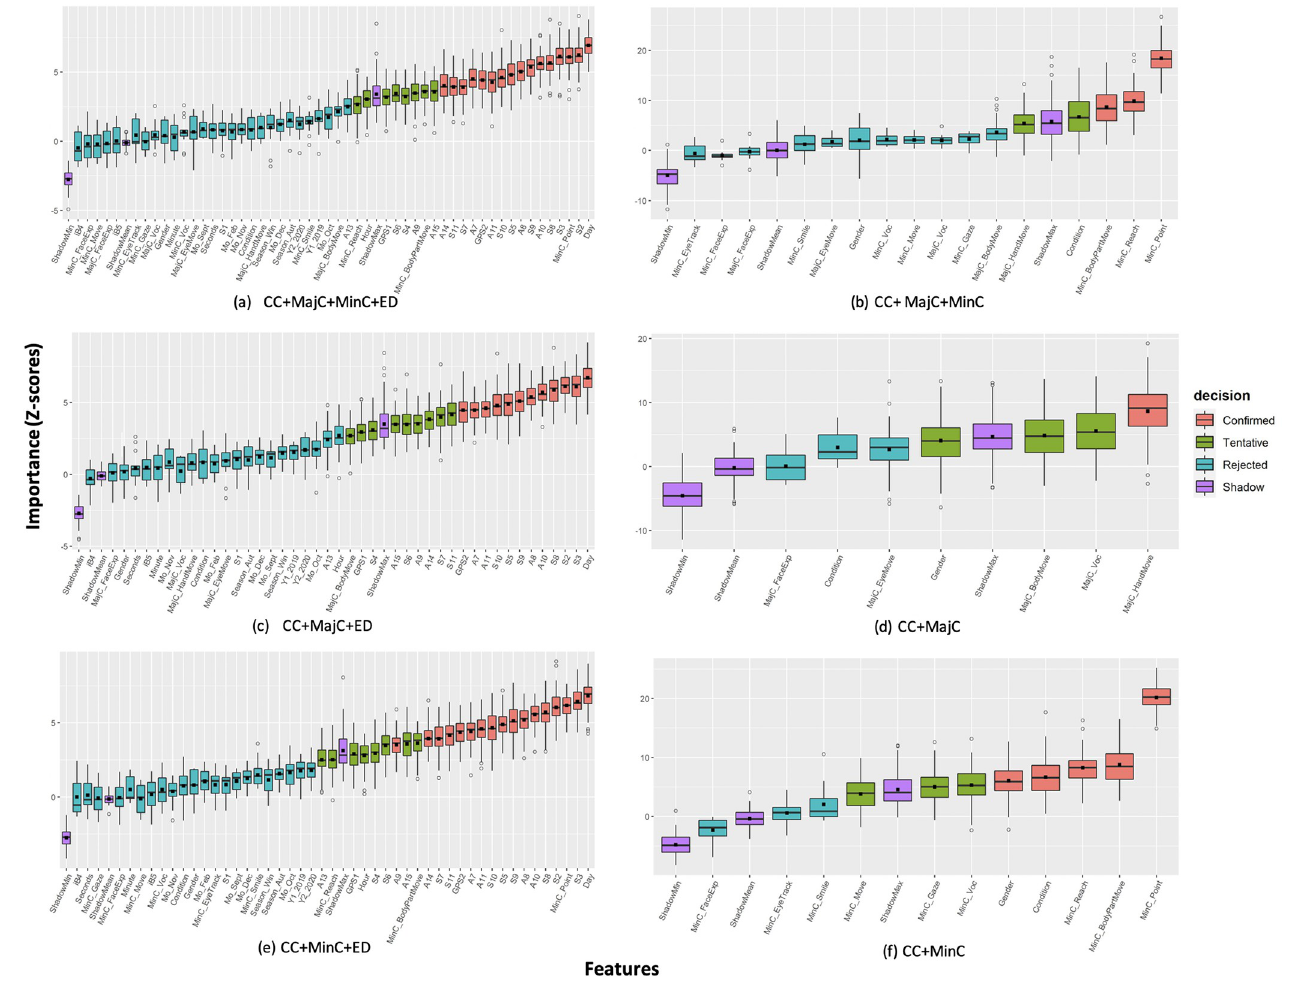
Fig 6. Variable importance ranking based on Boruta feature selection method in class 2. CC = child characteristics; MajC = major movement category; MinC = minor movement category; ED = environment data; Condition = PIMD or IDs; MinC_Gaze = gazing; MinC_ChangeLOS = changing line of sight; MinC_FaceExp = facial expression (other than smile); MinC_Voc = vocalization as minor category; MinC_Point = pointing; MinC_Reach = reaching; MinC_Move = moving; MinC_Appro = approaching; MinC_BodyPartMove = movement of a part of the body; MajC_EyeMove = eye movement; MajC_FaceExp = facial expressions; MajC_Voc = vocalization as major category; MajC_HandMove = hand movements; MajC_BodyMove = body movements; GPS1: Longitude; GPS2: Latitude; iB4 = classroom; iB5 = other iBeacon device; S1: Ultraviolet (UV) range (mW/cm2); S2, S3, S4: 6-axis (Accel+Geomag) sensor ranges [g]; S5, S6, S7: 6-axis (Accel+Geomag) sensor resolutions [ μ T]; S8: UV resolution [Lx]; S9: Pressure sensor range (hPa); S10: Temperature and humidity sensor range (˚C); S11: Temperature and humidity sensor resolution (%RH); A7: Minimum temperature (˚C); A8: Maximum temperature (˚C); A9: Atmospheric pressure (hPa); A10: Main temperature (˚C); A11: Humidity (%); A13: Cloudiness (%); A14: Wind direction (degrees); A15: Wind speed (meters/ second); Mo_Feb = February; Mo_Sept = September; Mo_Oct = October; Mo_Nov = November; Mo_Dec = December; ShadowMin = minimum Z-score of a shadow attribute; ShadowMax = minimum Z-score of a shadow attribute; ShadowMean = average Z-score of a shadow attribute.